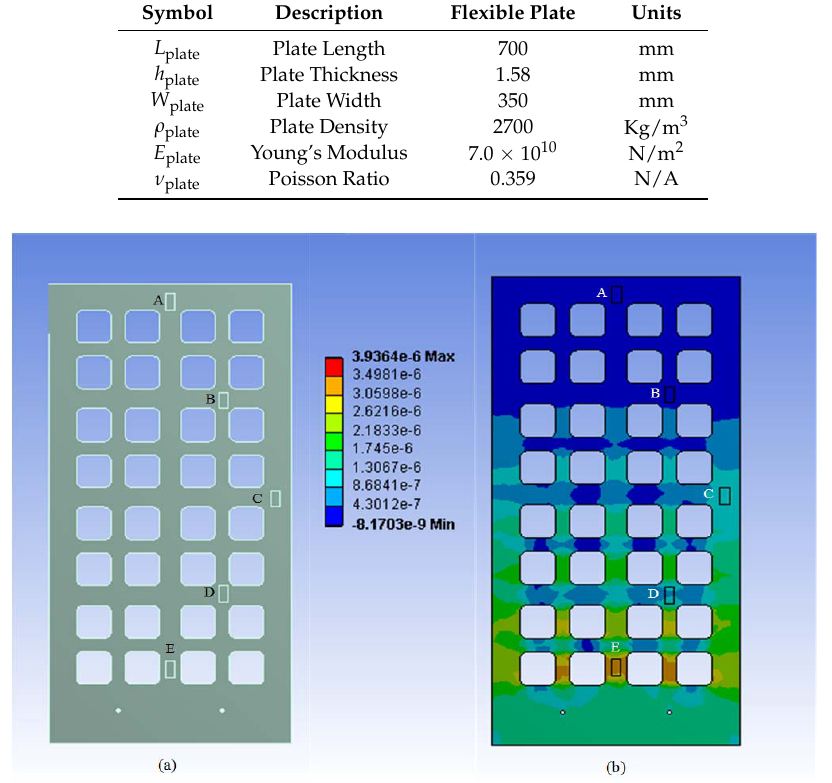
Figure 8. Modal analysis of flexible structure under persistent excitation: ( a ) illustration of the structure used for modal analysis; and ( b ) strain distribution throughout entire structure. Capital letters refer to the five locations used in evaluating the placement of piezoelectric sensors.